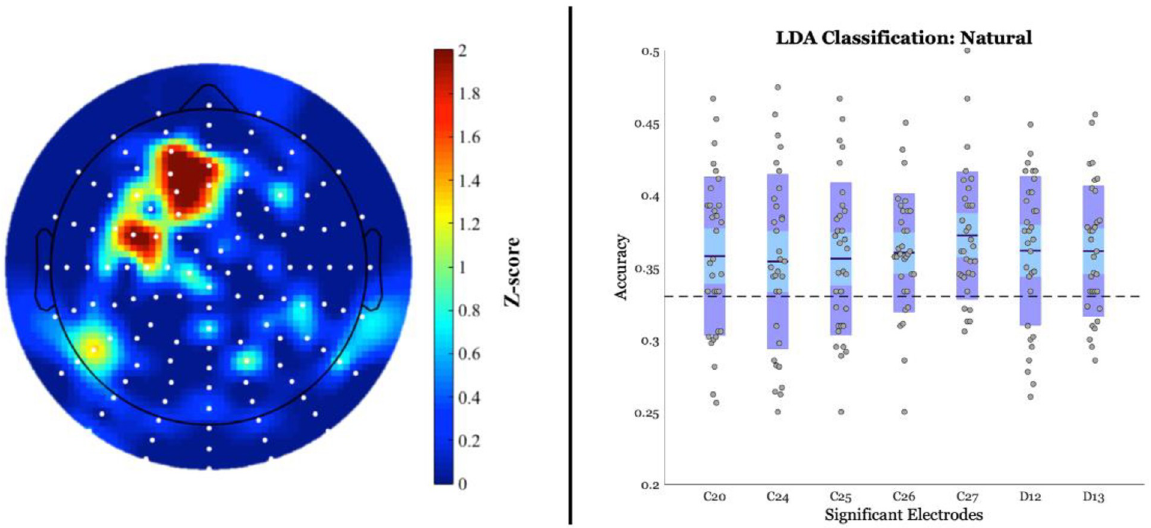
Fig 4. Left panel : A statistical z-score map of LDA accuracies for the natural category . Significance was defined as a one-tail probability value of z > 1.64 (p < 0.05) and can be observed in 7 channels that served as searchlight origins (dark red regions) in left fronto-central sites. Right panel : Classification accuracies for the 7 significant channels. Each gray dot represents the accuracy of a single participant. The expanse of the box (purple) represents one standard deviation, the blue middle strip represents the standard error of the mean (SEM) for the 95% confidence interval, and the blackline represents the mean. The dashed line represents chance level (i.e., 1/3 classes, or.33).